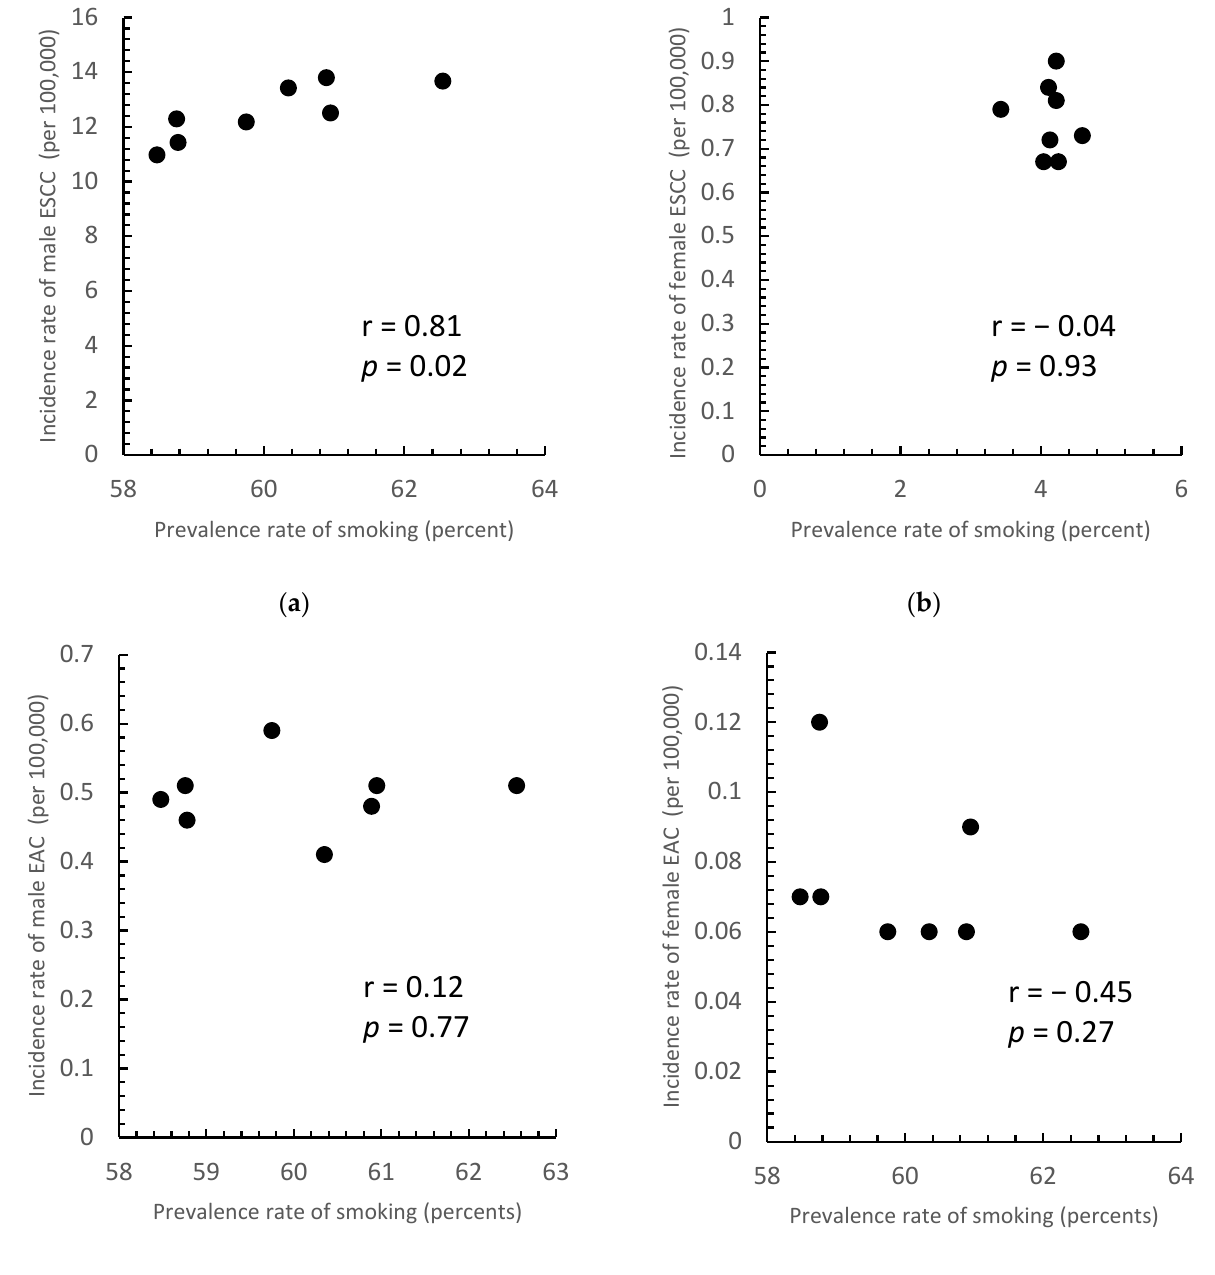
Figure 5. Correlation between the prevalence of smoking in 1971–1982 and the incidence of esophageal squamous cell carcinoma (ESCC) and adenocarcinoma (EAC) by sex for the period 2006–2017. ( a ) ESCC in men; ( b ) ESCC in women; ( c ) EAC in men; ( d ) EAC in women.